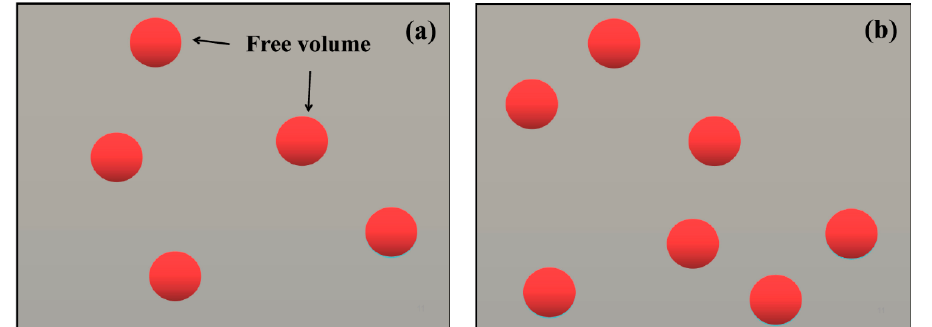
Figure 1. ( a ) XRD patterns of (TiZr) 0.5 (Ni 0.6 Cr 0.1 V 0.1 ) 2.1 amorphous ribbons with different spinning speeds; ( b ) shapes of (TiZr) 0.5 (Ni 0.6 Cr 0.1 V 0.1 ) 2.1 amorphous ribbons; ( c ) the model of ribbons in the tensile test; ( d ) stress–strain curves of amorphous (TiZr) 0.5 (Ni 0.6 Cr 0.1 V 0.1 ) 2.1 alloy with different spinning speeds. Table 1. Tensile strength, elongation, and elastic modulus of amorphous (TiZr) 0.5 (Ni 0.6 Cr 0.1 V 0.1 ) 2.1 ribbons at different spinning